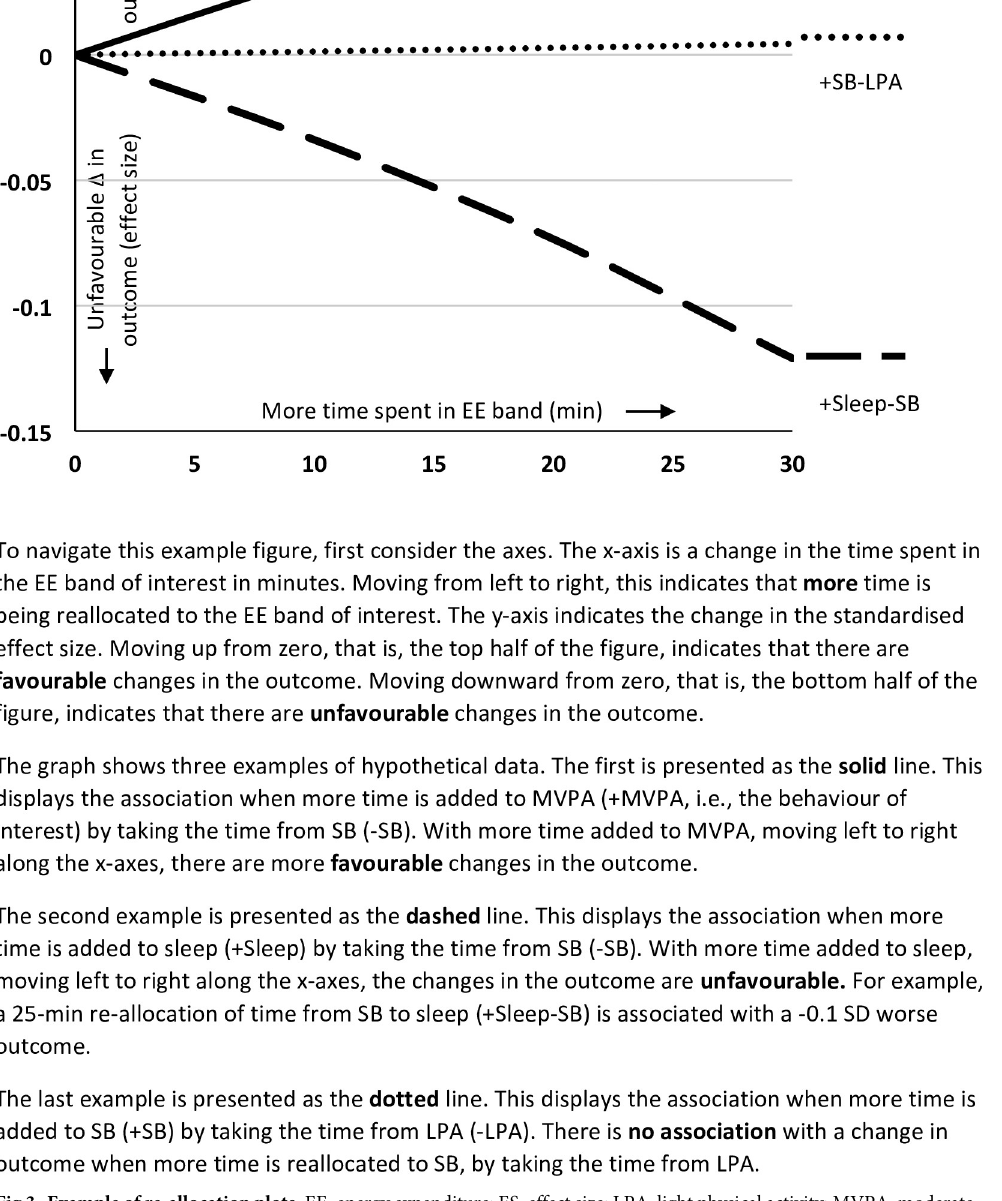
Fig 3. Example of re-allocation plots. EE, energy expenditure; ES, effect size; LPA, light physical activity; MVPA, moderate to vigorous physical activity; S, sleep; SB, sedentary behaviour.